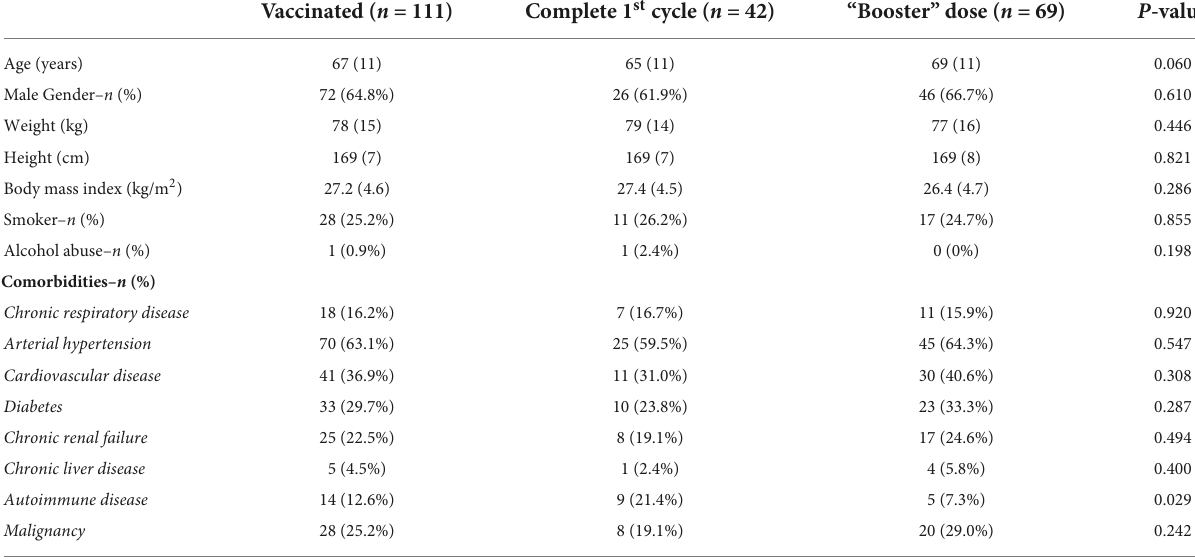
TABLE 3 Demographic characteristics and comorbidities–Comparison between patients with first complete cycle of vaccination versus “booster” dose. Vaccinated ( n = 111)